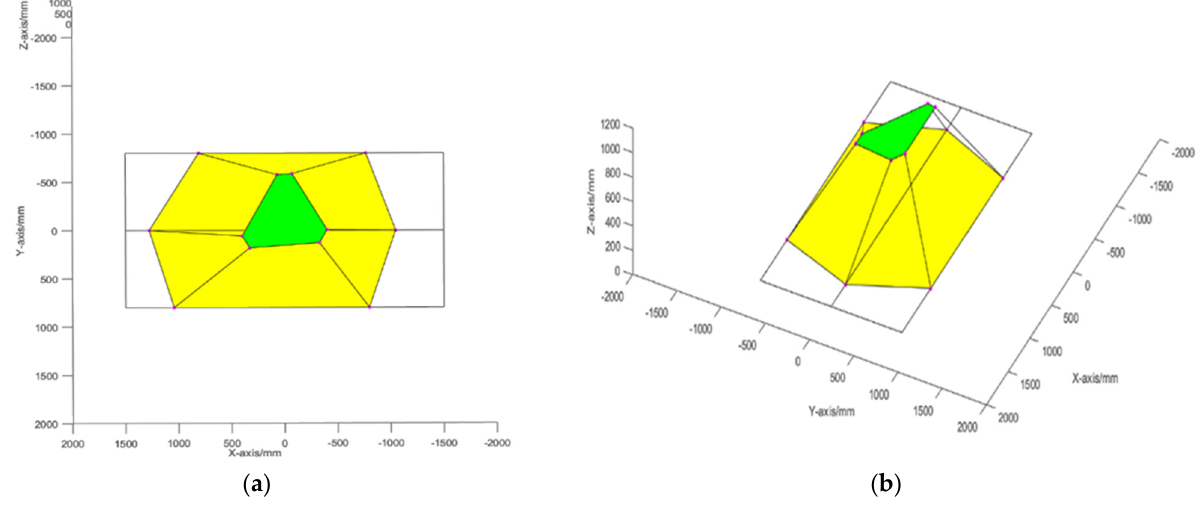
Figure 7. Pose of the robot when the roll angle = 20 degrees. ( a , b ) show the results from different perspectives.